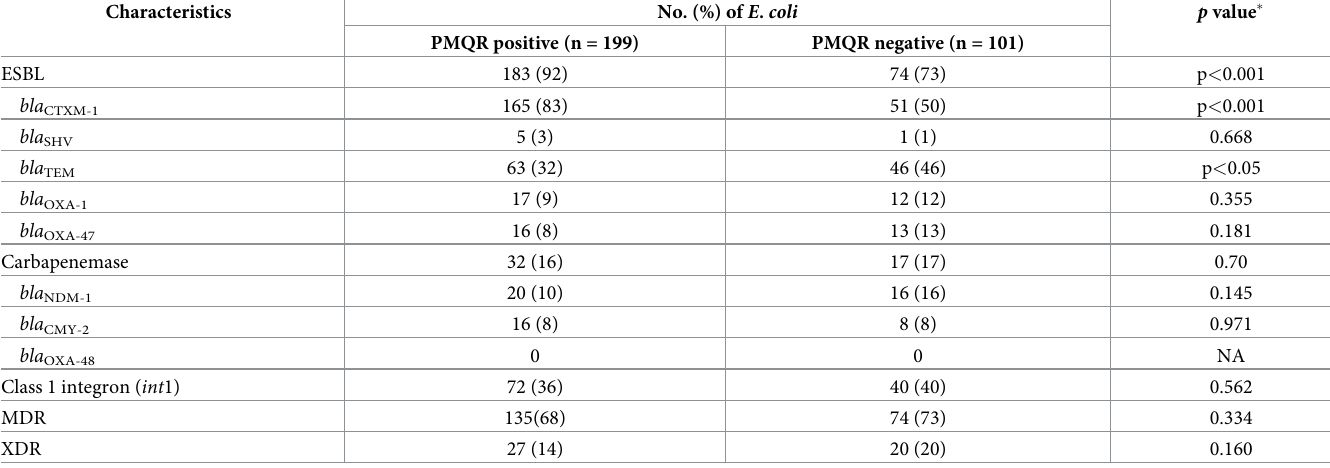
Table 4. Association of PMQR genes with ESBL, carbapenemase, integrase genes, and MDR and XDR phenotypes in E . coli isolates. Characteristics